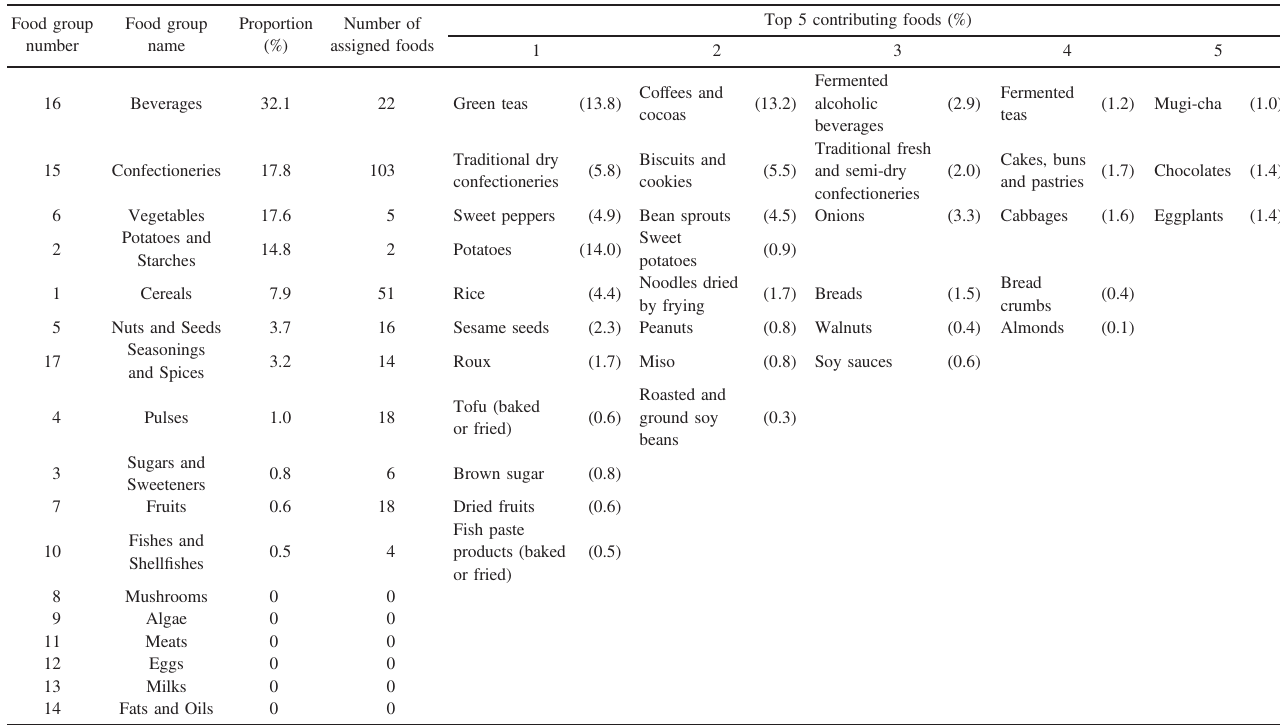
Table 3. Contribution to total acrylamide intake by food groups from DRs Food group Food group number